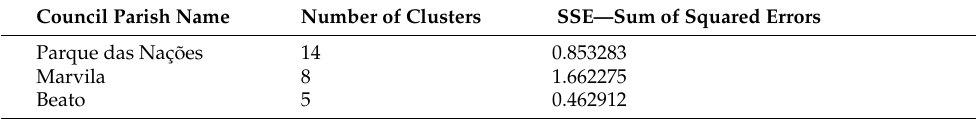
Table 2. SSE—Sum of Squared Error for best K, following Elbow method